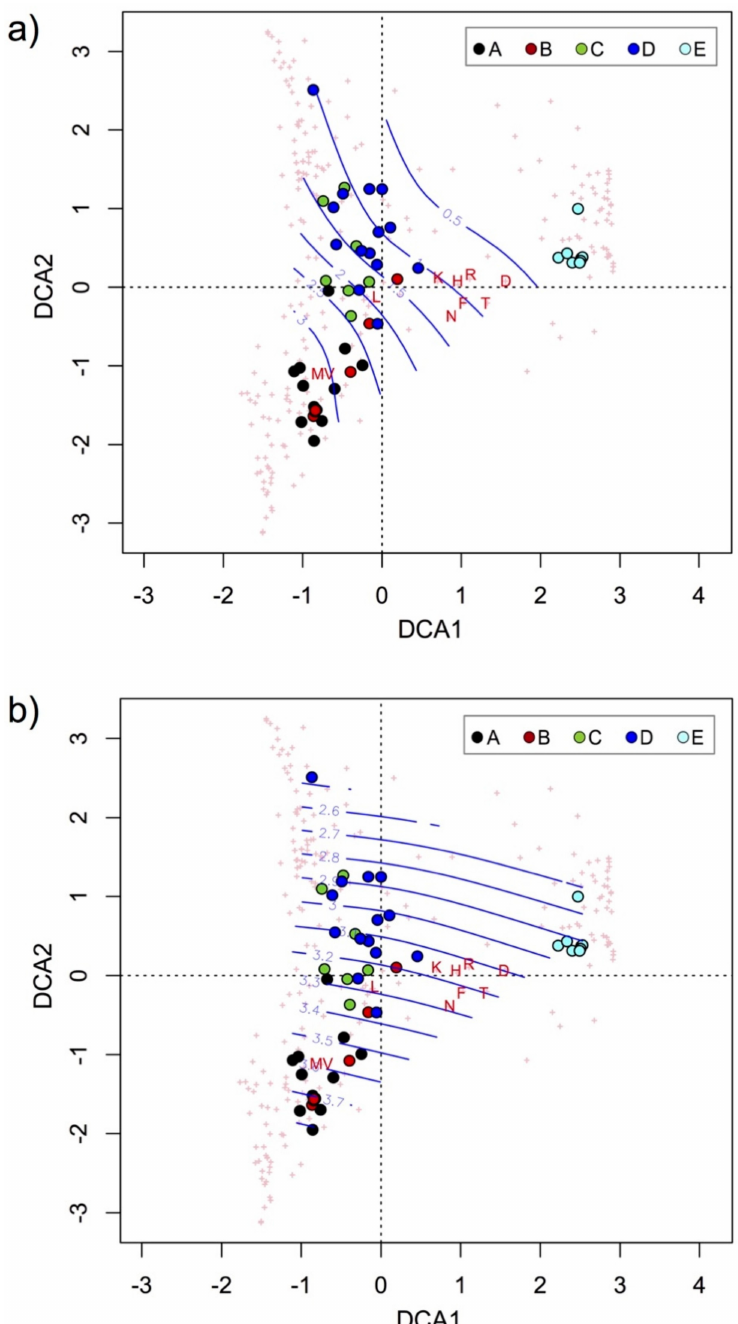
Figure 3. DCA ordination of relev é s overlapped with the MV (mowing tolerance, ( a ) and N (index of nutrients, ( b ) contour lines. The points indicate the relev é s: A, meadows (number of species: 98); B, meadows-pastures (number of species: 87); C, pastures (number of species: 89); D, shrublands (number of species: 173); E, forests (number of species: 84). Landolt values (T, index of temperature; K, index of continentality; L, index of light intensity; F, soil moisture index; R, index of substrate reaction; N, index of nutrients; H, index of humus; D, aeration index; MV, mowing tolerance) and species (crosses) are plotted. Eigenvalues for the first four axes of DCA are reported in Table